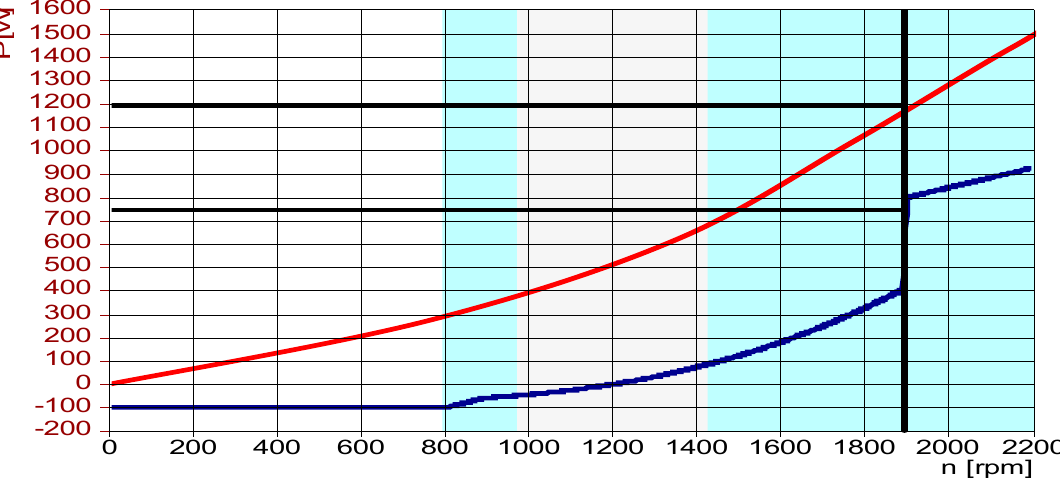
Figure 13. A wind turbine based on DFIG with a high speed of 12.5 m/s.